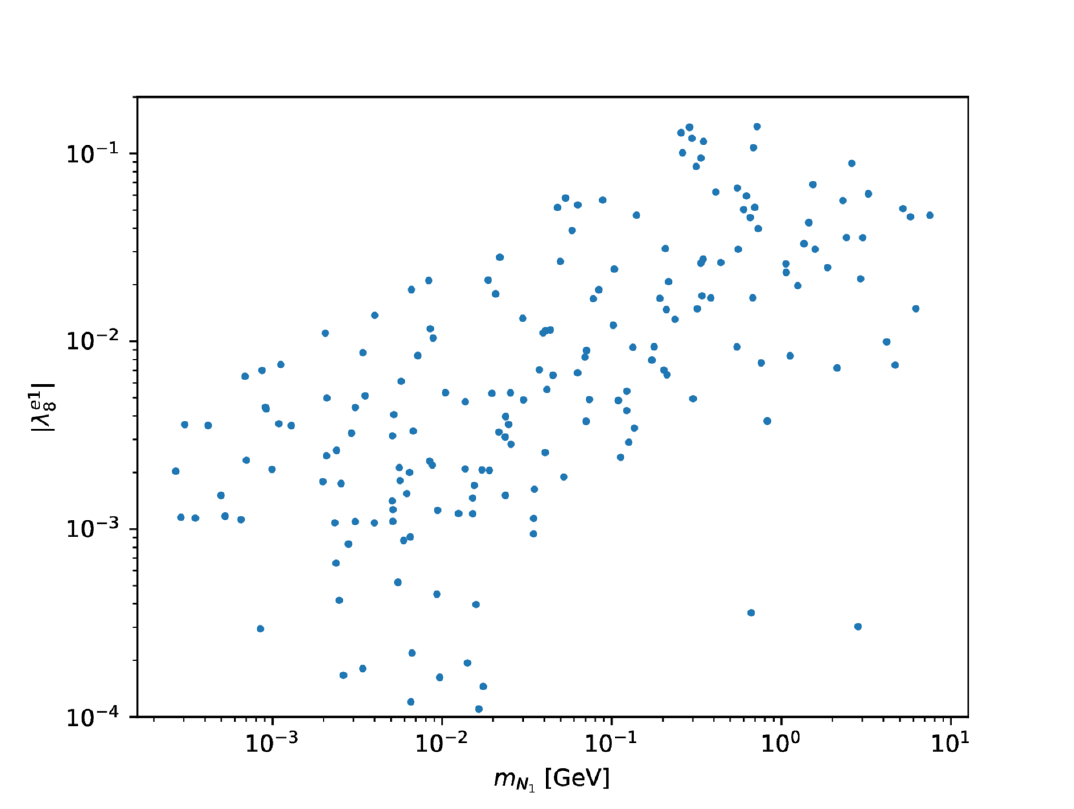
versus DM mass m N for models which satisfy not only 8 1